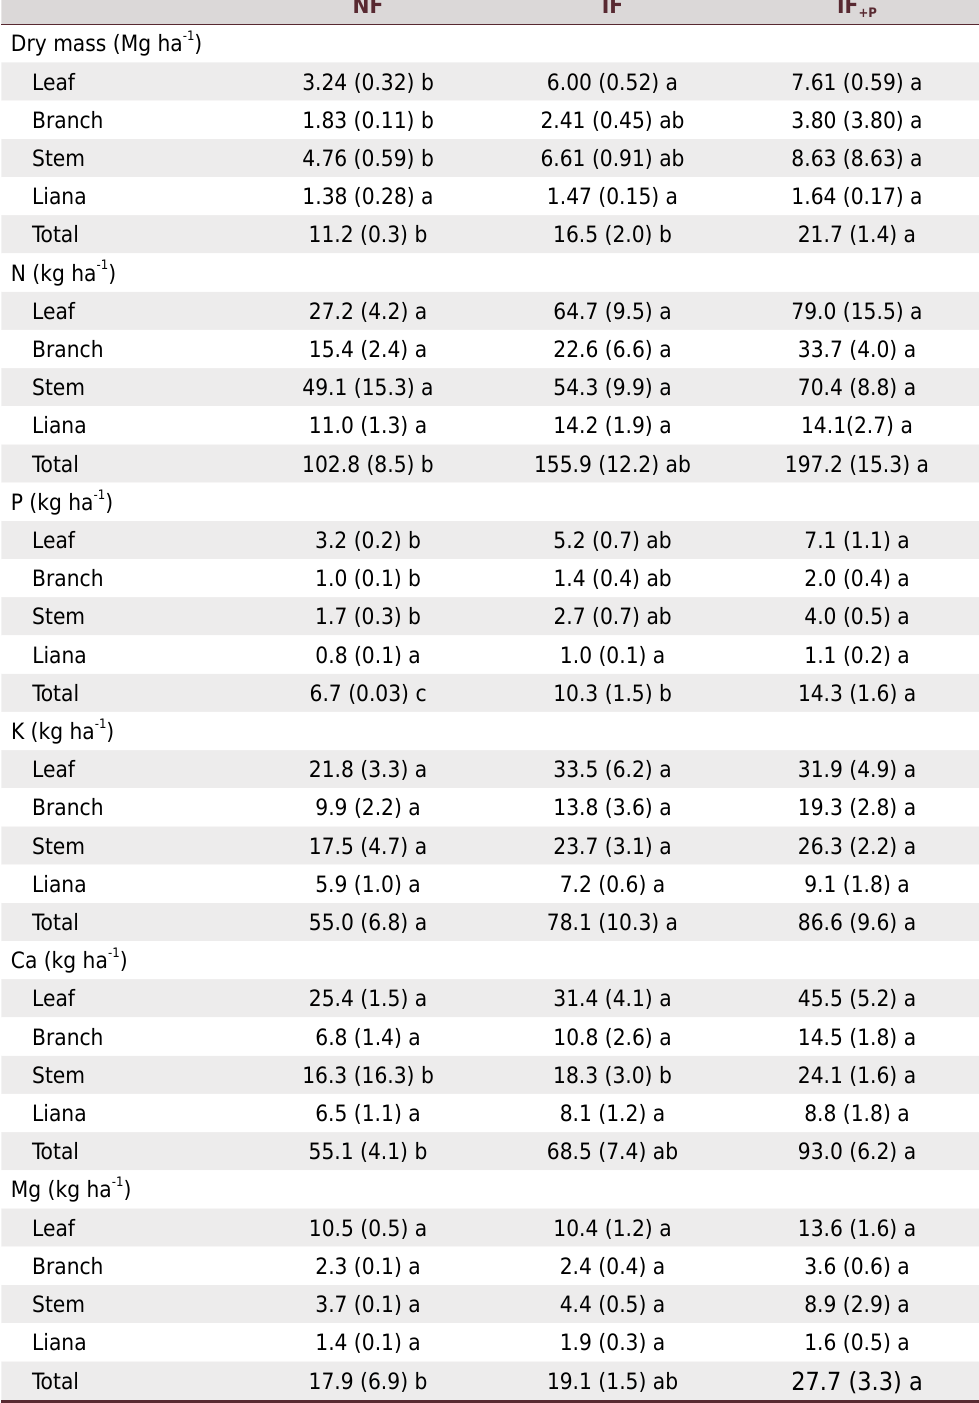
N extracted with sulfuric acid and peroxide; P, K, Ca, and Mg extracted with nitroperchloric solution. Standard errors in parentheses. Different letters in the same row indicate that treatment means differ significantly for a biomass compartment at a significance level of 5 % (Tukey’s